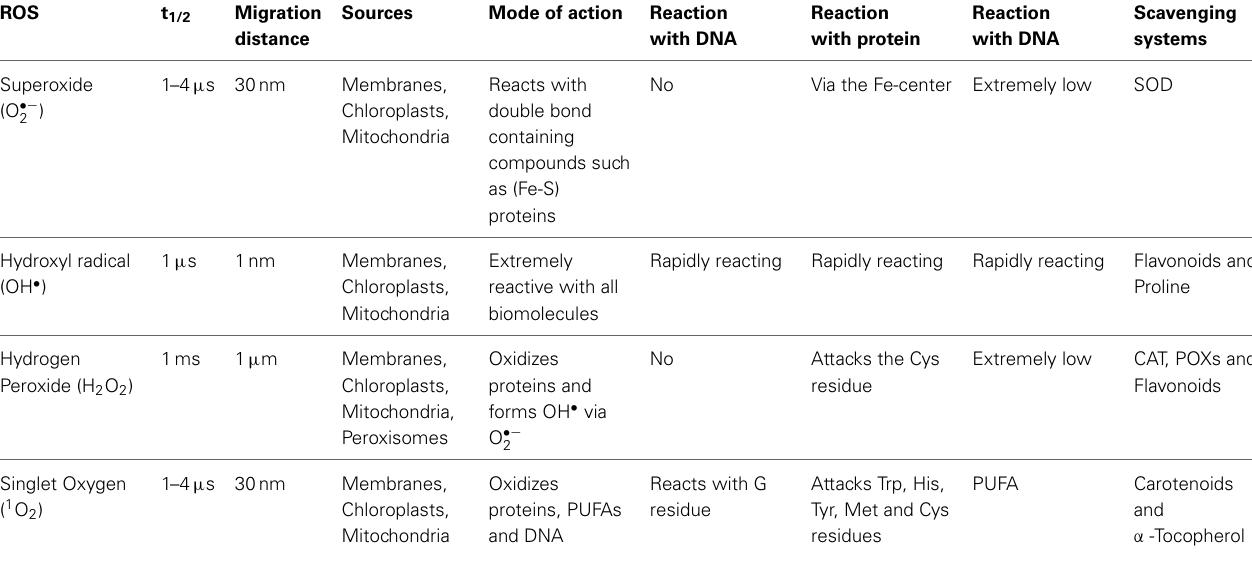
Table 1 | Different members of the ROS family and their attributes.